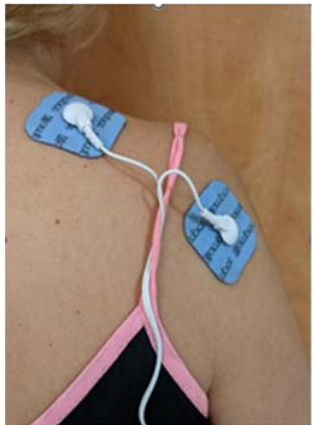
Figure 1. Example of FES electrode placement.